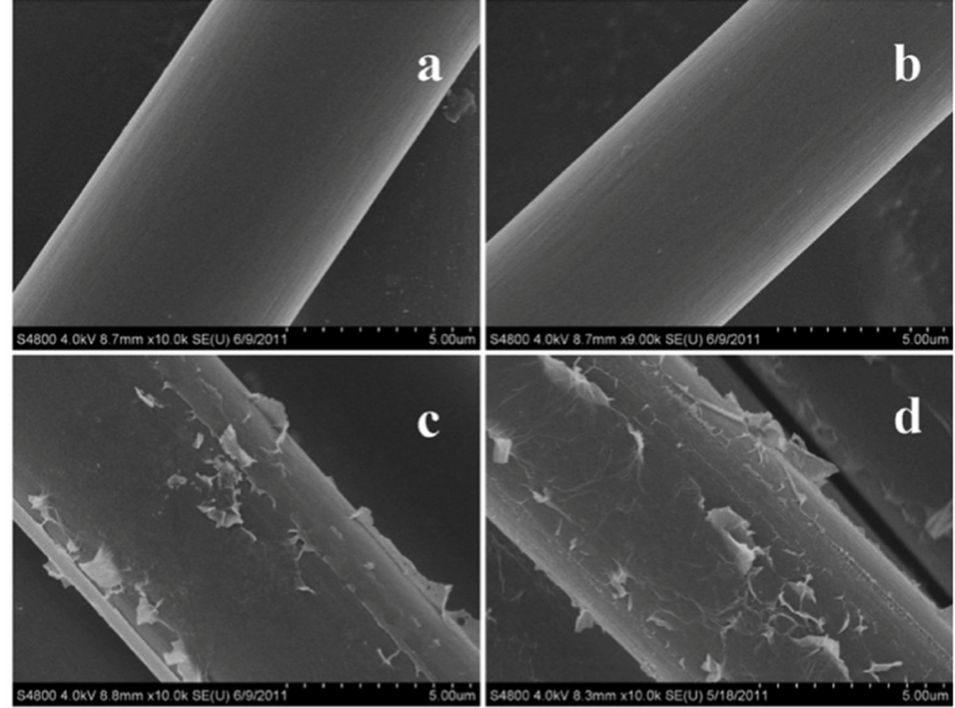
Figure 4. SEM images of ( a ) pristine carbon fiber; ( b ) CF-GO0; ( c ) CF-GO1; ( d ) CF-GO5 [45]. Obtained with permission from American Chemical Society; published by ACS Publications,